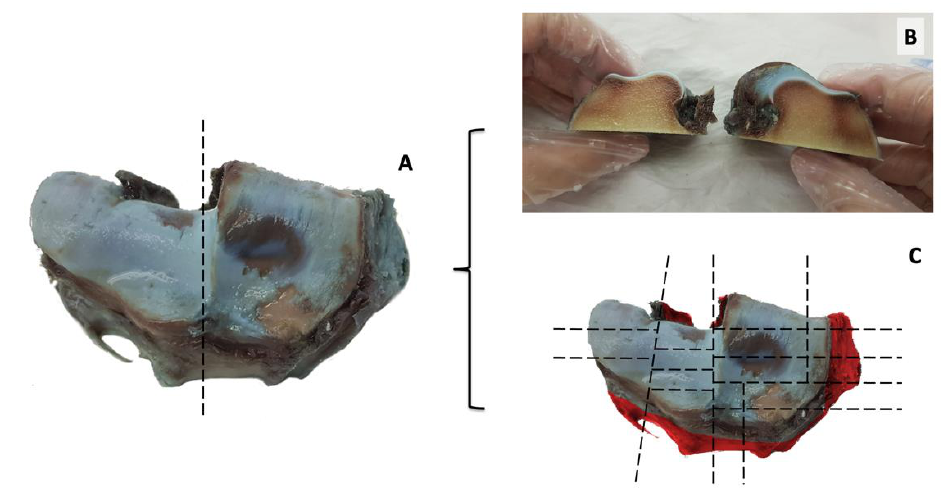
Figure 3. Macroscopic aspect of the articular surface of the distal radius. The articular surface is visualized after dissection of the radio-carpal joint, and Indian ink deposition. Hyaline articular cartilage is severely damaged, as shown by extensive erosion on the radial facet ( A ). A first cut was performed along the dotted line presented in A ( B ). Multiple cutlines are planned in the articular surface of the radio-carpal joint to capture lesions in the entire hyaline articular cartilage surface at histopathology ( C ).